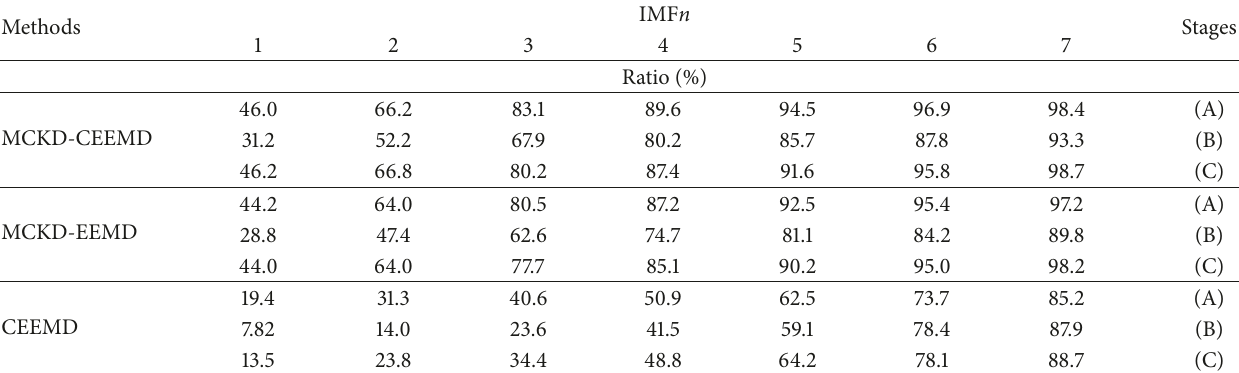
Figure 12: Characteristic parameters of Stage (C). Table 2: Ratio of parameter: correlation coefficient.